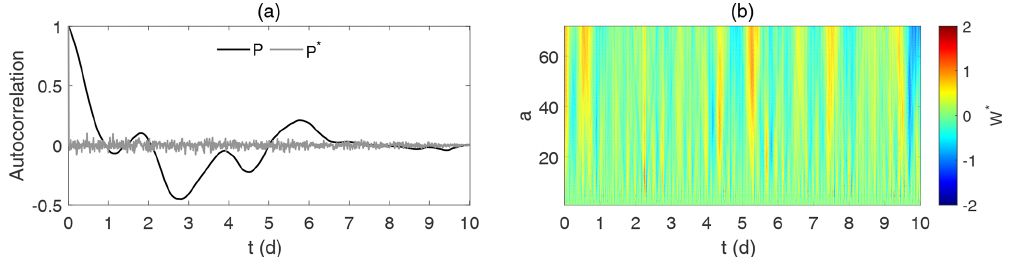
Figure 2. (a) The auto-correlations of the original wind power ( P ) and the normalised wind power surrogate ( P ∗ ); (b) the CWT of the normalised wind power surrogate.